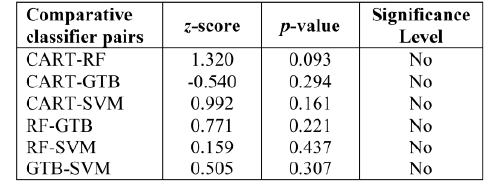
Table 3 . z -scores and p -values for classifier model